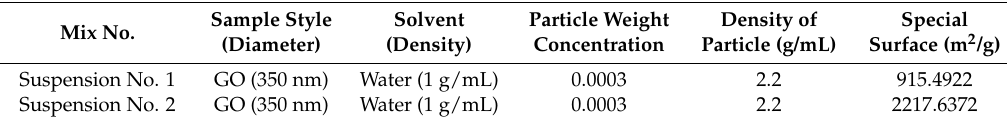
Table 5. Graphene oxide surface parameters and particle size characteristics.